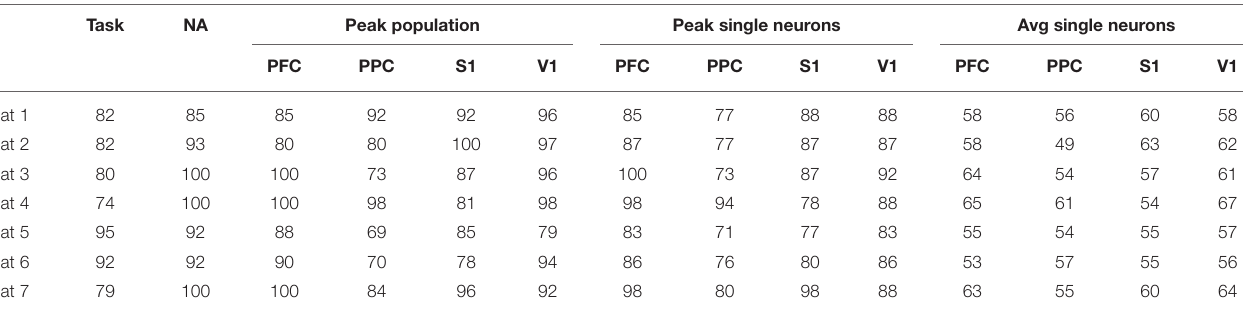
TABLE 3 | Performance summary (%).